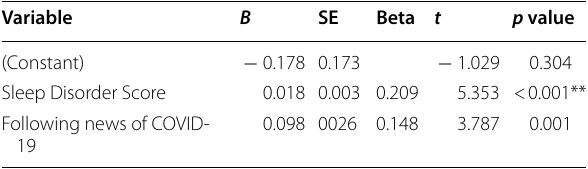
Table 5 Predicting variables of anxiety score by linear stepwise regression analysis